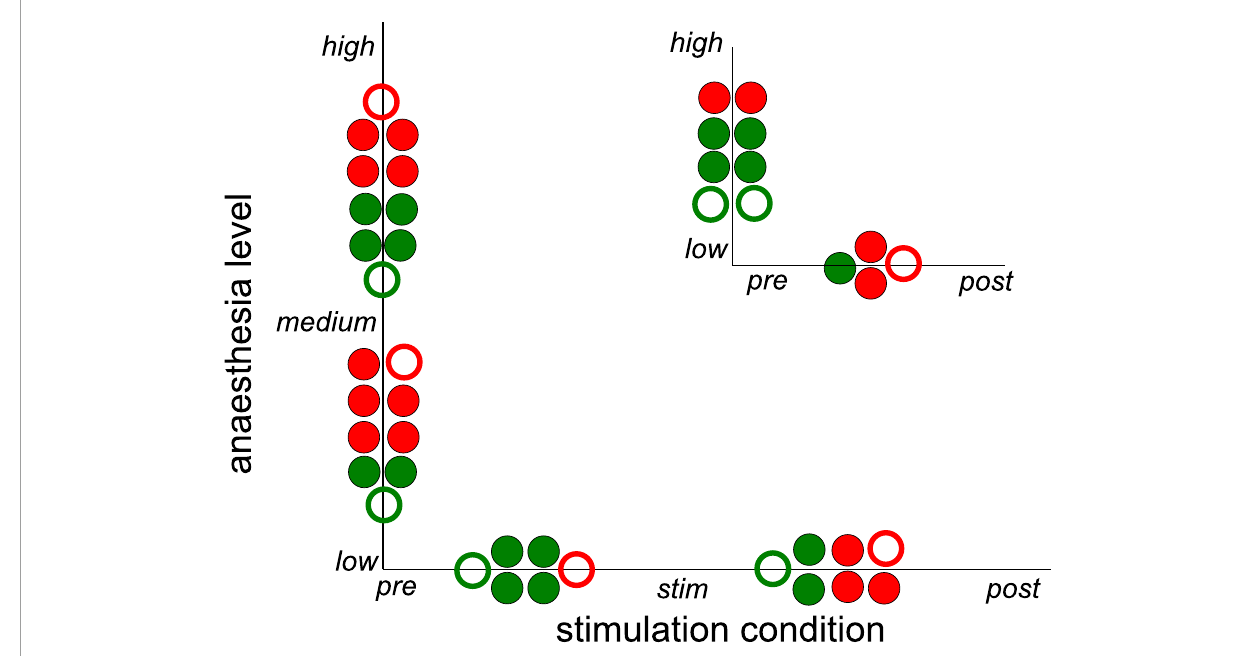
FIGURE5 Significant impact on synchronization of stimulation condition and anesthetic level in single animals. Circles between two conditions or levels indicate statistically significant differences between median Phase Locking Values (PLVs) in channel clusters C2 and C3 in single animals. Full and empty circles indicate data computed for slow oscillations and γ -frequency band, respectively. The colors indicate increased (red) and decreased (green) synchronization. The significance level is α = 0.05. The plot summarizes results contained by Supplementary Tables 1 , 2